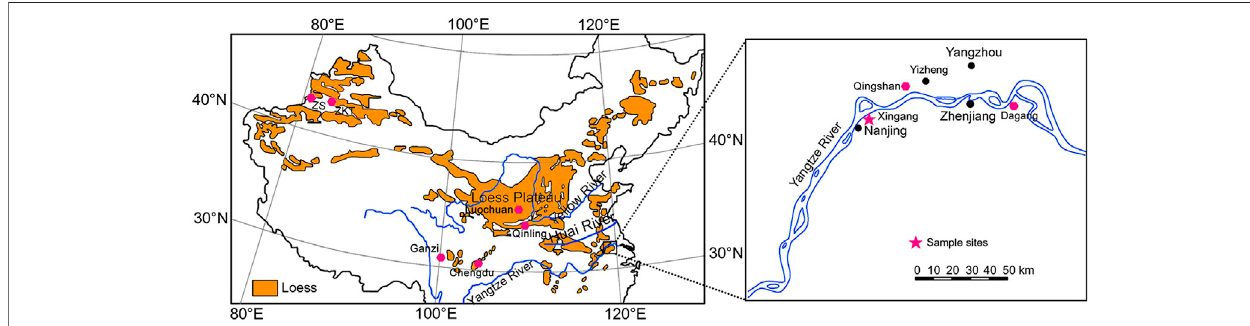
FIGURE 1 | Loess distribution in China (Liu, 1985; Li et al., 2018b) and sampling locations.